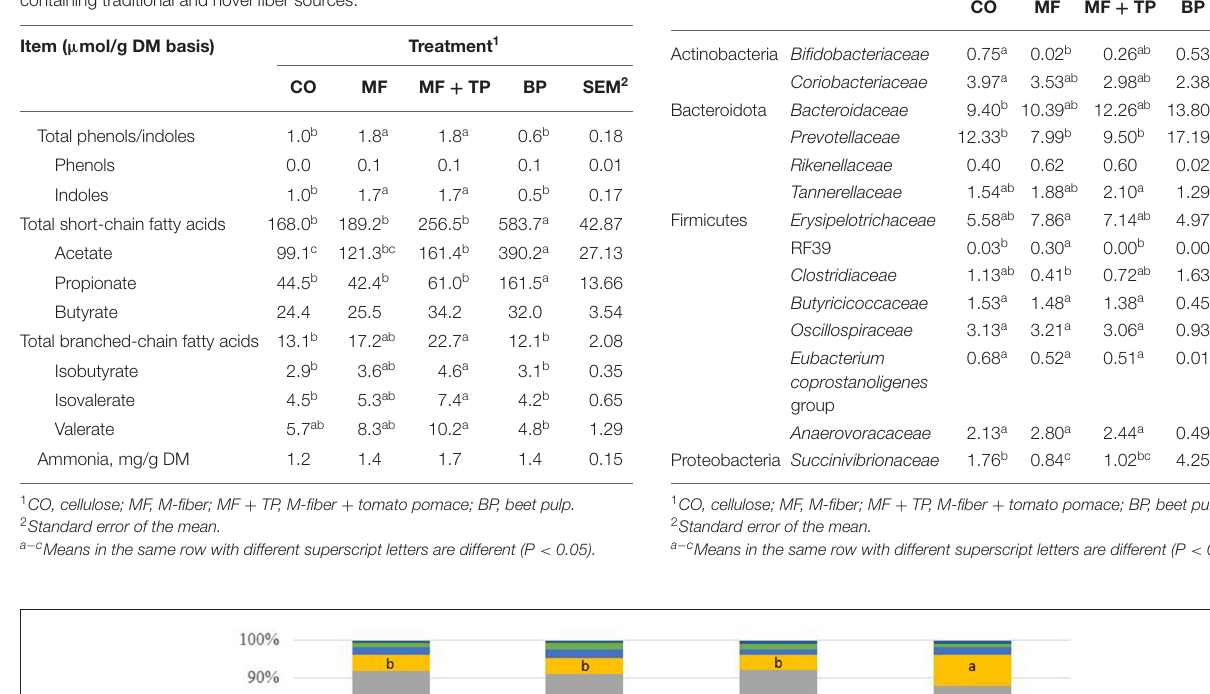
Frontiers in Veterinary Science |